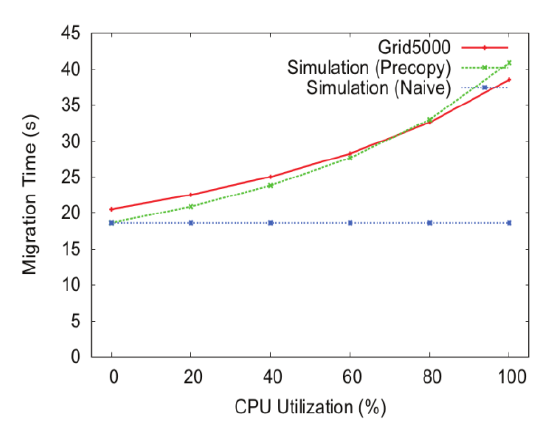
Figure 7 . Comparison of Real Migration Time and Simulation